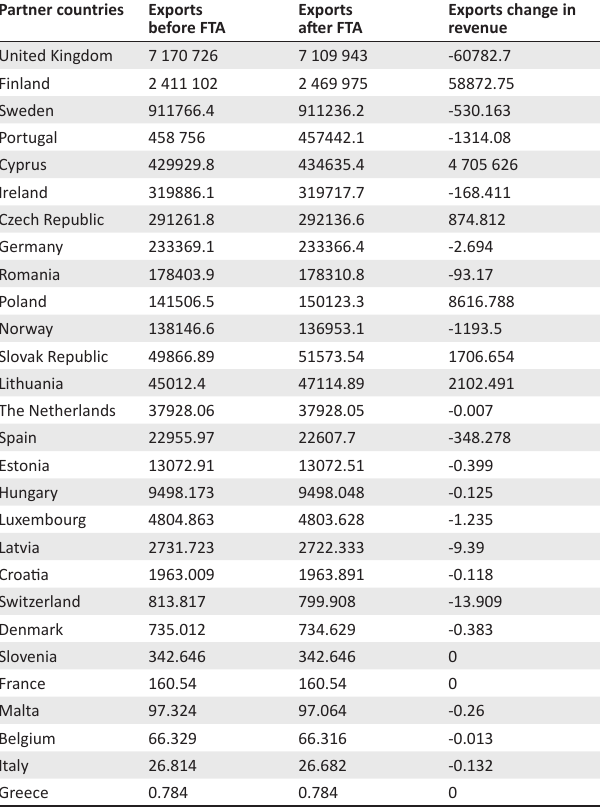
TABLE 9: The impact of European Union Free Trade Agreement on South Africa TABLE 8: Increase in exports of individual European Union countries after Free imports (US$ 1000). Trade Agreement with South Africa (US$ 1000). Partner countries Imports Partner countries Exports Exports Exports change in before FTA before FTA after FTA